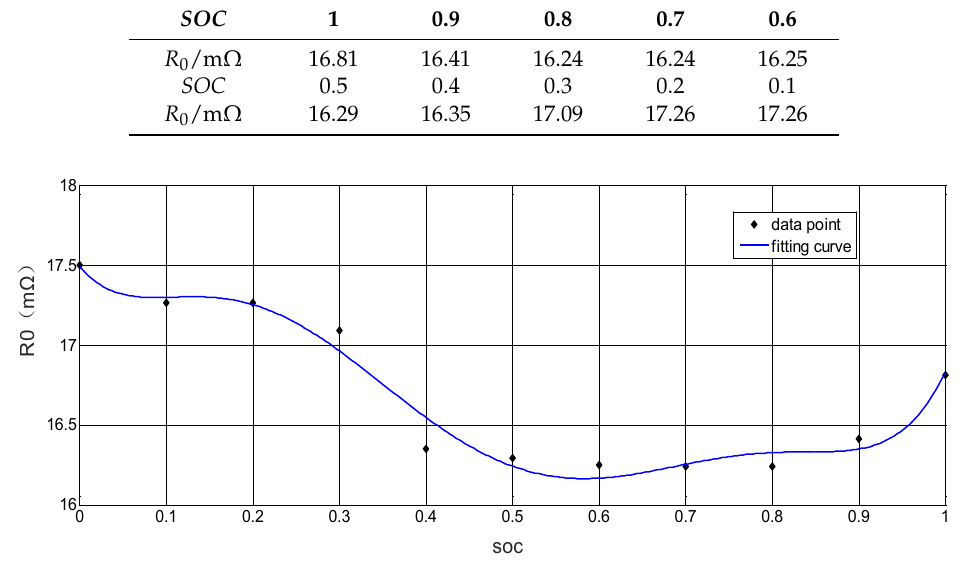
Figure 3. Change curve of internal resistance of battery discharge. 146